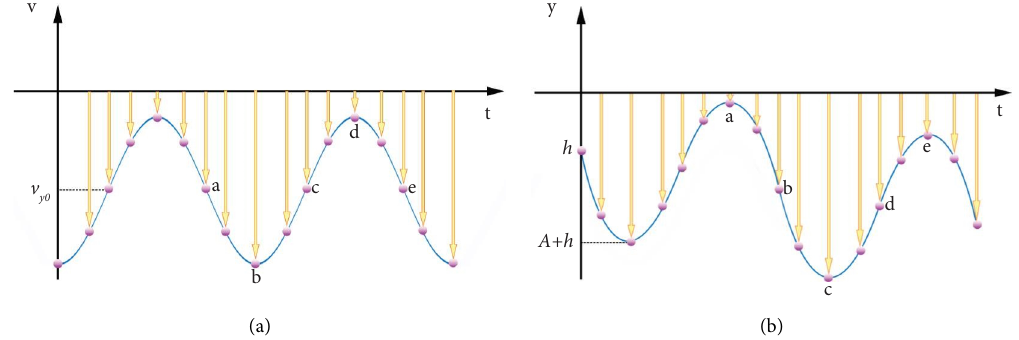
Figure 5: Disc cutter velocity and displacement curve along the vertical direction: (a) velocity; (b)